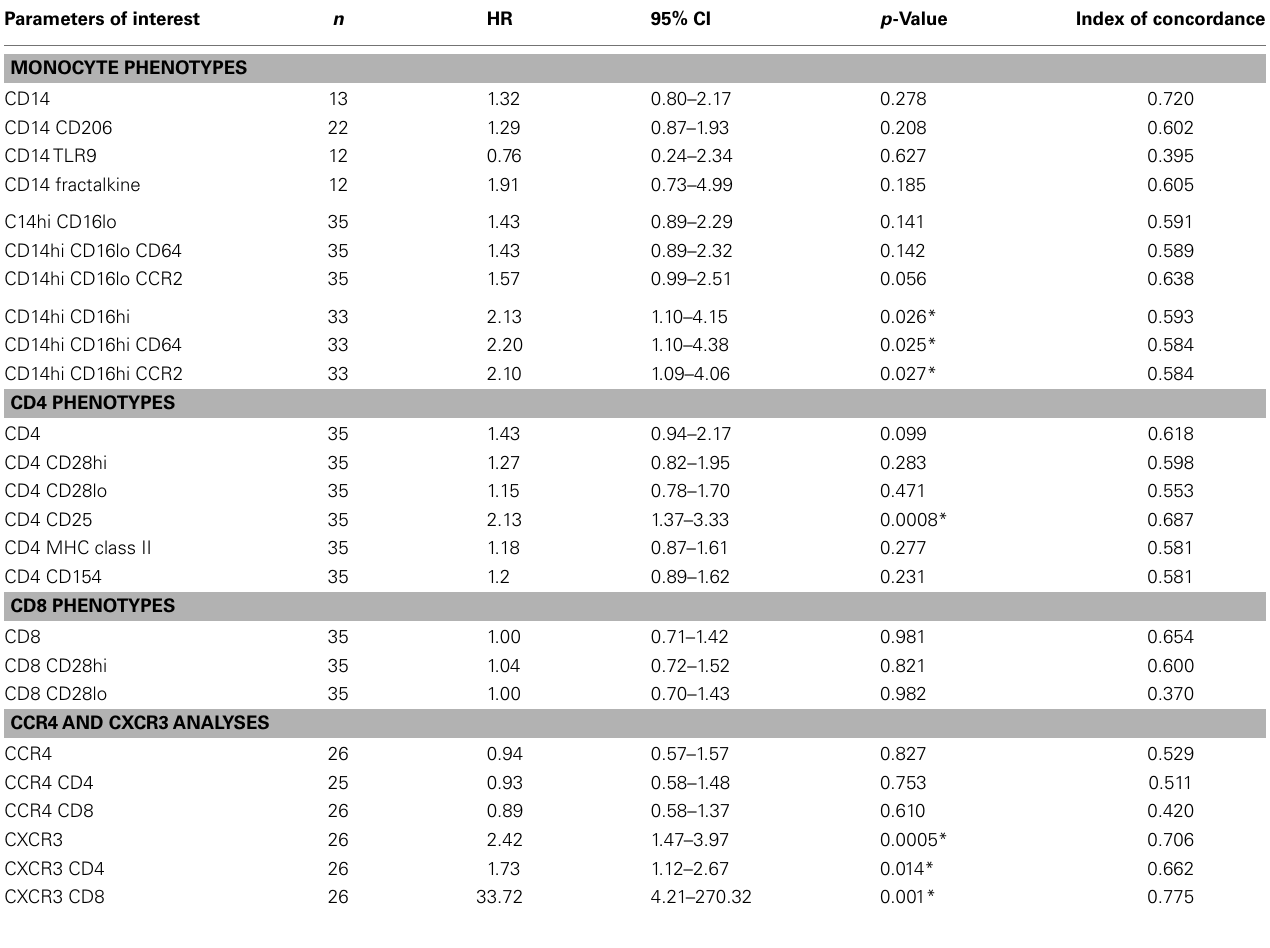
Table 2 | Univariate Cox model results based on standardized biomarker level values